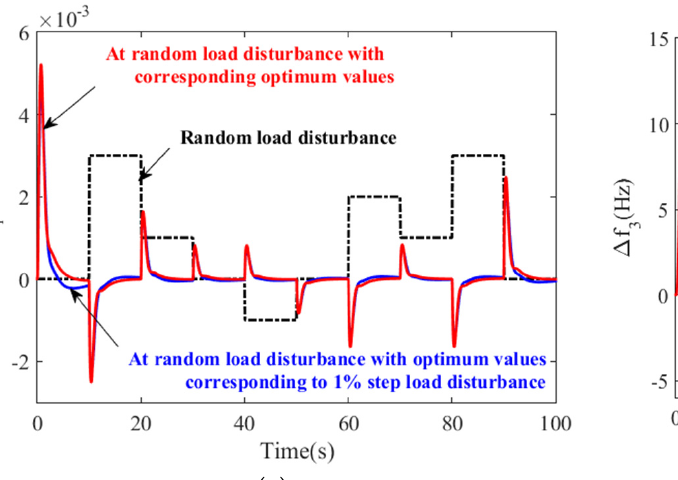
Figure 11. Valuation of influence of C ES with/without duple compensation on scheme dynamics employing SHO-optimized PDN(FOID) controller taking into account 1% step load disturbances for system-5 and system-6 individually contrast time: ( a ) Anomaly of frequency in area-2, ( b ) Anomaly of frequency in area-3, ( c ) Anomaly of Tie-line power interlinking area-1 and area-2, ( d ) Anomaly of Tie-line power interlinking area-1 and